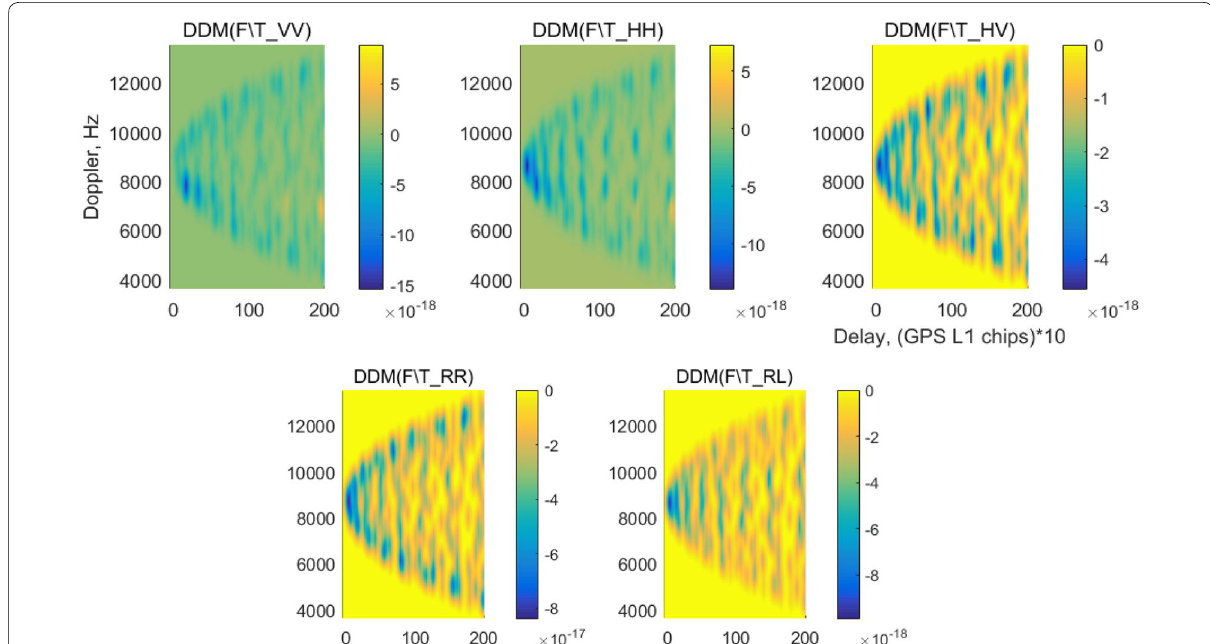
Fig. 4 The DDM differences at linear (HH, VV and HV) and circular (RR and RL) polarization, when the bare soil changes from frozen sate and thawn state